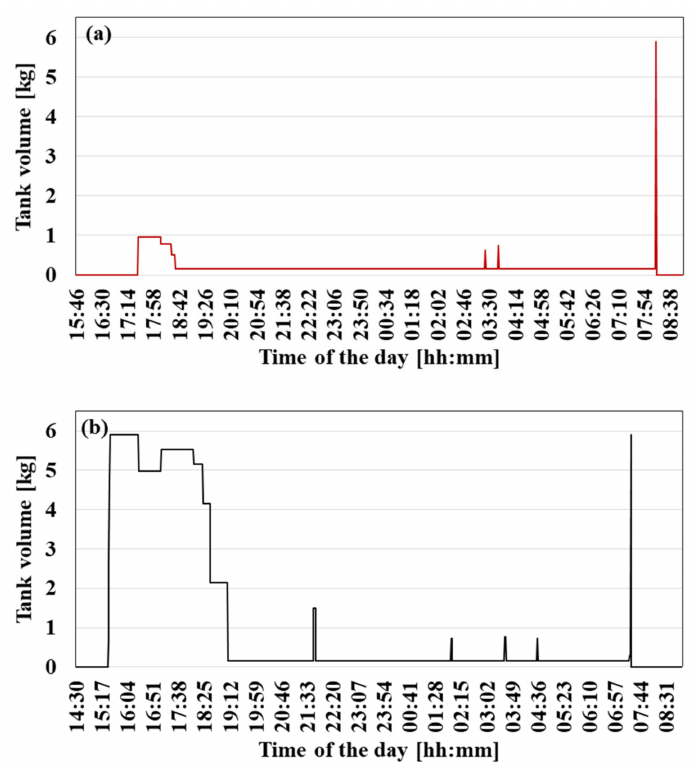
Figure 12. Variation in hydrogen molar at hydrogen tanks of FCEV4 ( a ) and FCEV16 ( b ) in Case-2. Data on the amount of power curtailment in the absence of the power system for Case-1, Case-8 and Case-10 are given in Figure 13. It should be said that all of the resiliency- sensitive loads are interrupted in Case-1, which is economically operated. On the other hand, in Case-8 without CESS and Case-10 without CESS and PV (the aim in both case studies is to minimize curtailment), the curtailment is realized as 4.27 kWh and 5.96 kWh, respectively. CESS has a greater impact than PV systems and FCEV energy support. In addition, in Case-2, which is the recommended structure and curtailment is minimized, the total amount of interruption is 0.